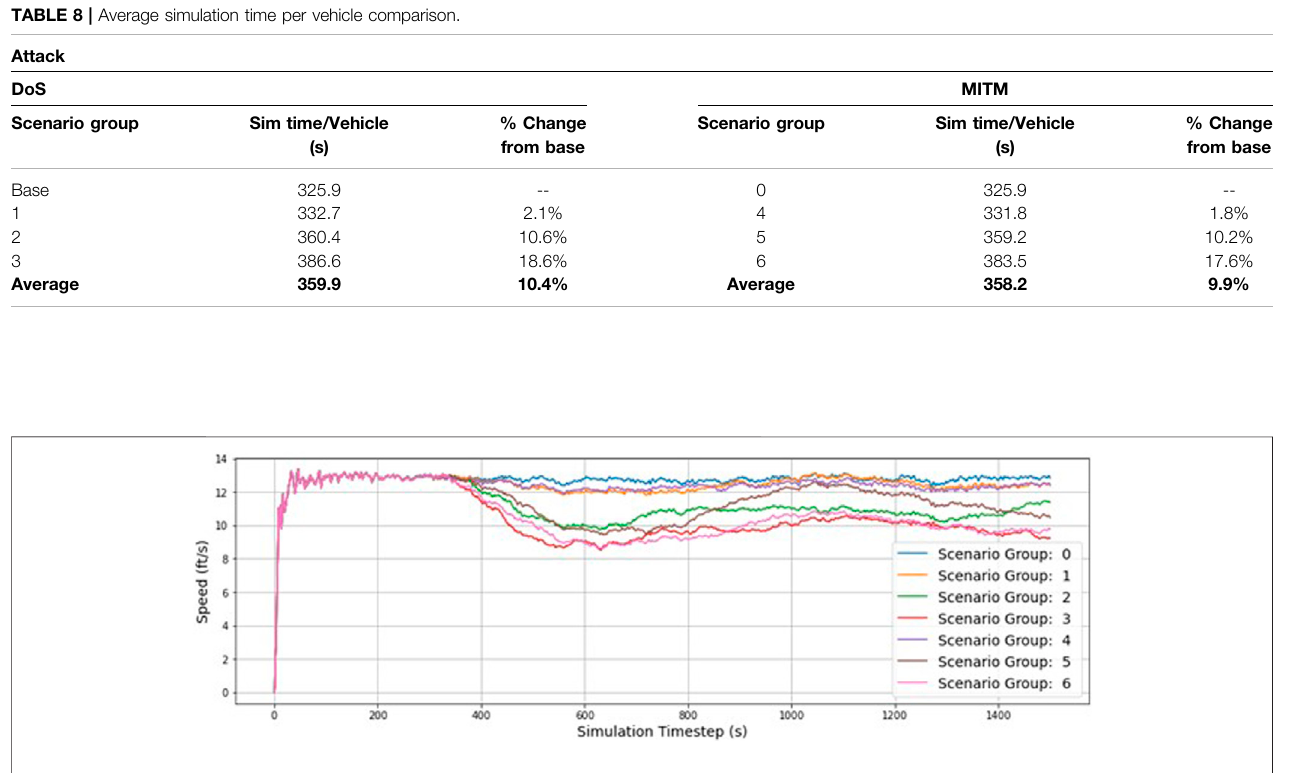
FIGURE 7 | Average speed per time step — all Scenario